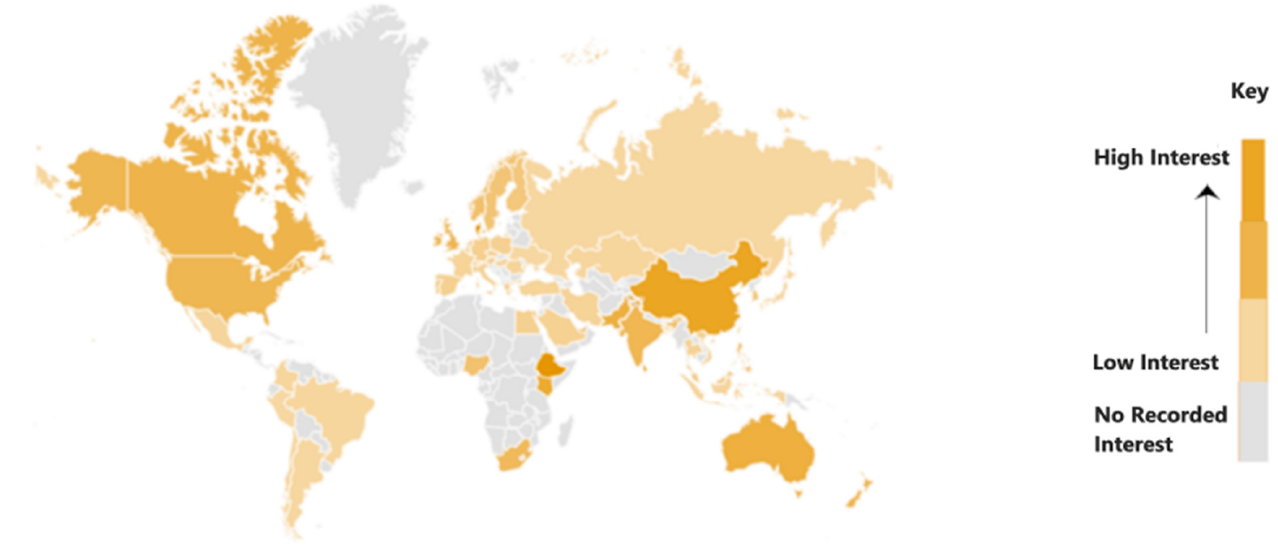
Figure 5. Map illustrating the interest in wind energy over the past 5 years [15].